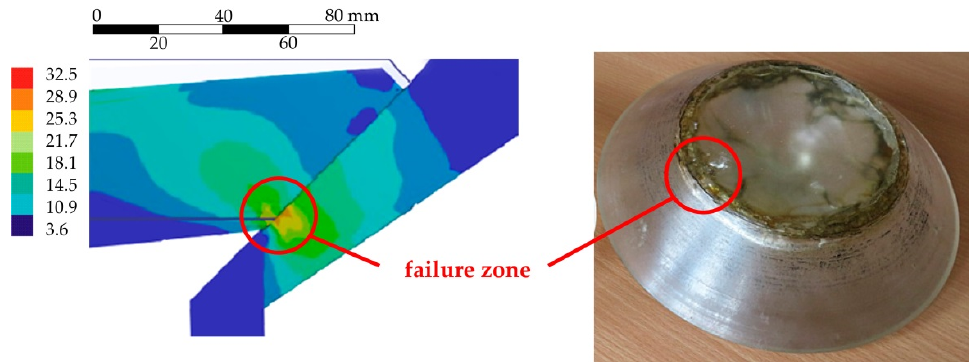
Figure 9. Distribution of equivalent stresses and formation of annular cracks and wrinkling area at the edge of the low-pressure surface.